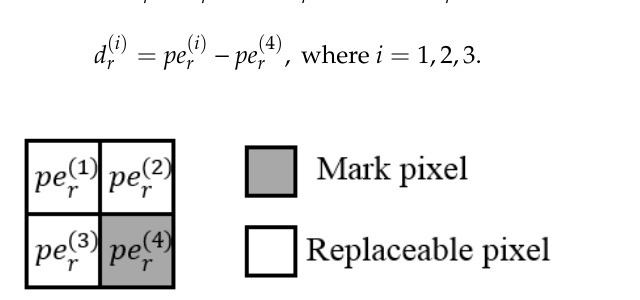
Figure 2. The mark pixel and replaceable pixels.